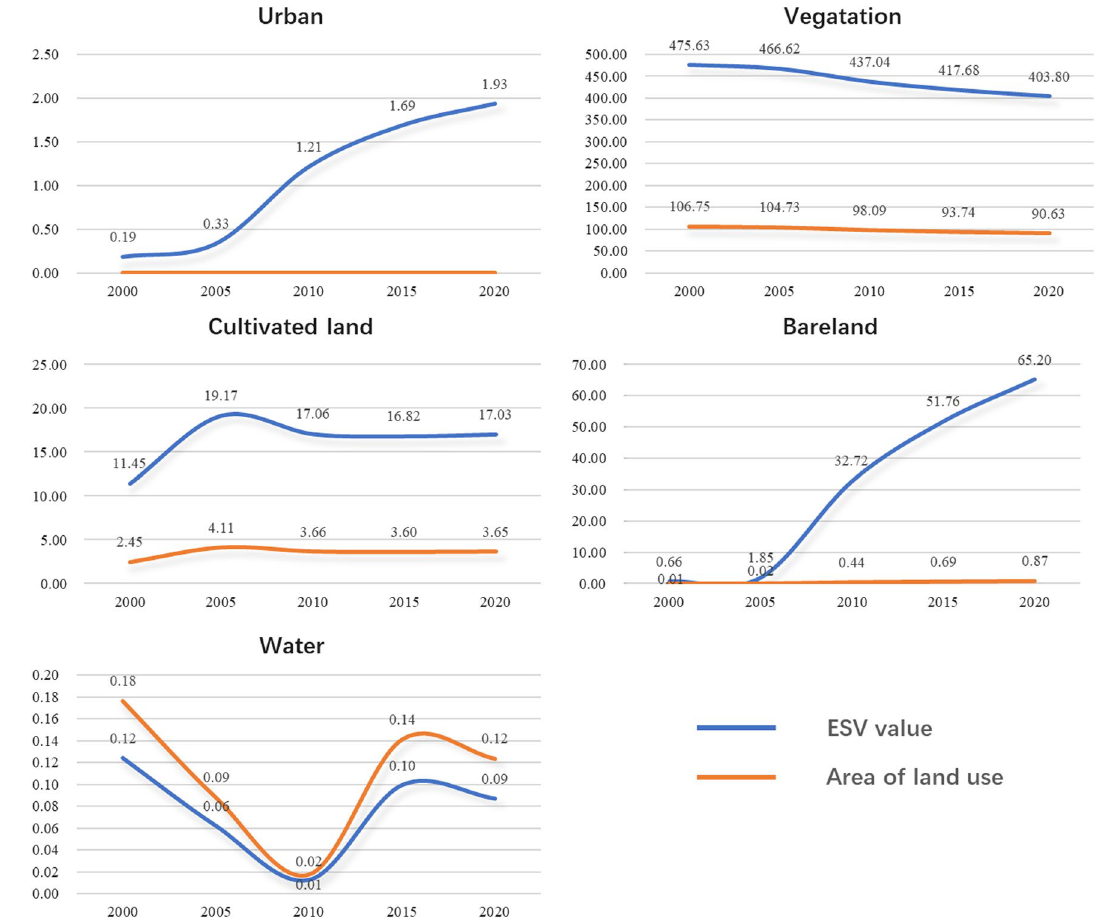
Fig. 7 Variations in land use area and ecosystem service value in 2000–2020 (The X -axes indicate year, and the Y -axes indicate variation in land use area. Blue lines indicate the ESV of the type of LUCC, and orange lines indicate the area of land use type